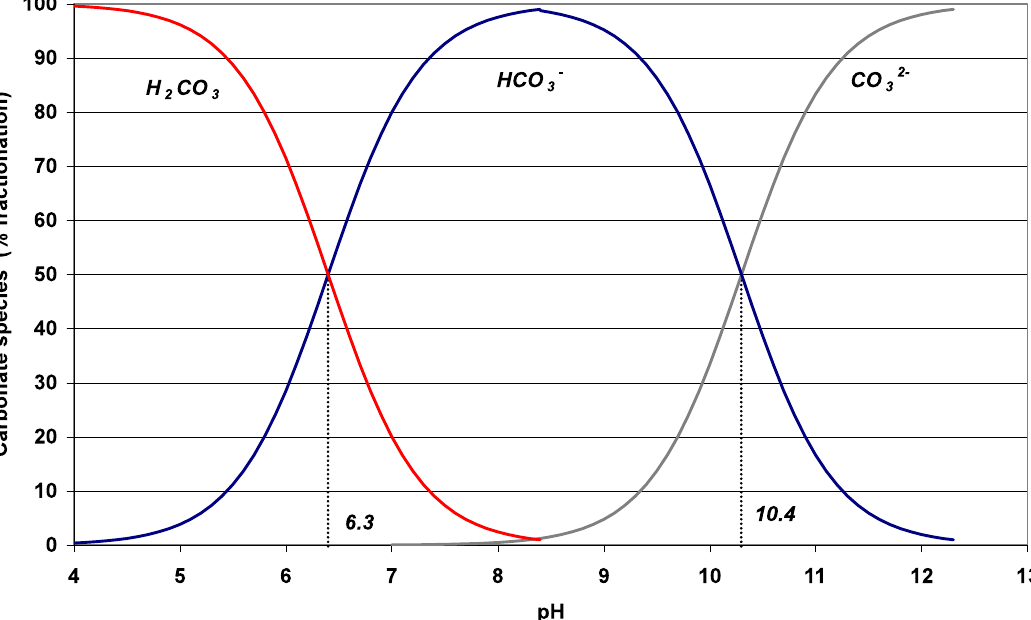
CO -HCO and HCO -CO 2 3 3 3 3